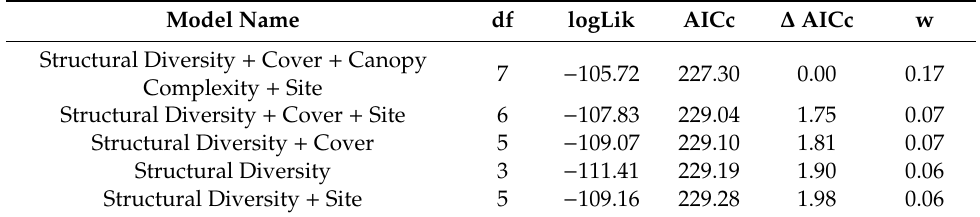
Table 3. Top five models as ranked by AICc for small mammal diversity for subplot–level analysis with degrees of freedom (df), log–likelihood values (LogLik), AICc values (AICc), delta AICc values ( ∆ AICc), and weight (w).